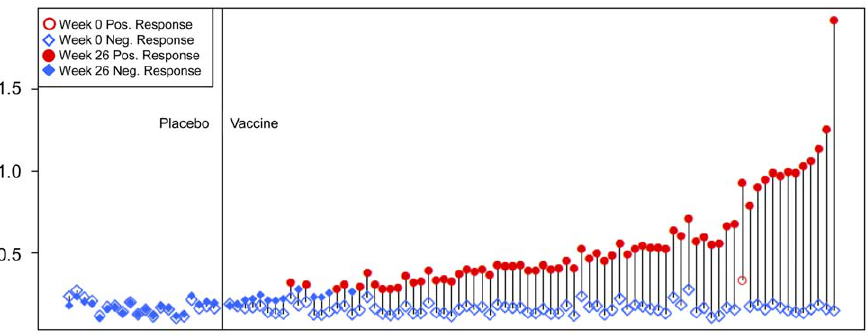
Figure 3. ELISA reactivity with gp70-V1V2 of plasma specimens used in the pilot studies of the RV144 clinical vaccine trial (Set C). The results from one of three experiments are shown. The open and filled blue diamonds depict negative responses at weeks 0 and 26, respectively. The open and closed red circles depict positive responses at weeks 0 and 26, respectively. Each vertical line connects a single patient’s specimen drawn at Week 0 and Week 26. The specimens are ordered by the difference in reactivity between the Week 0 and Week 26 specimens, with the biggest increasers on the right. Plasma were tested at a final dilution of 1:100, and a positive response was defined as being . 0.283, the cut-off OD value which was defined as the mean + 3 standard deviations based on values derived from vaccinees at week 0 (the pre-immunization time point).